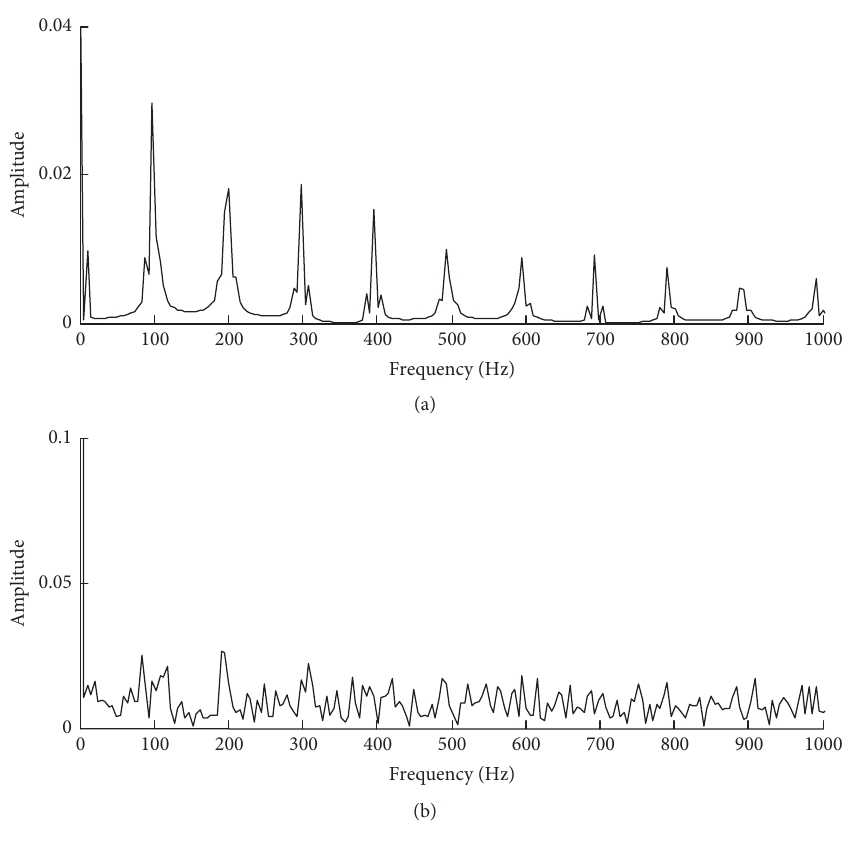
and simulation signal x . 1